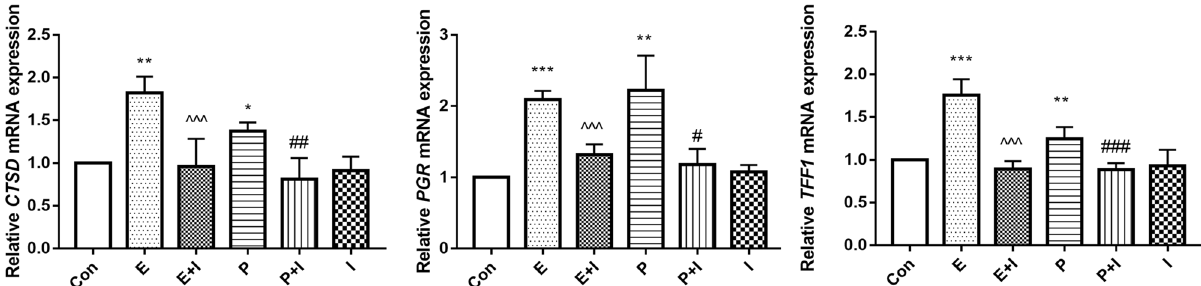
Figure 6. Effects of psoralen on the expression of estrogen target genes in hPDLCs. Cells were divided into 6 groups: Con, control group; E, estrogen (10 –8 M) group; P, psoralen (12.5 μg/mL) group; E + I, estrogen (10 –8 M) + I (1 μM) group; P + I, psoralen (12.5 μg/mL) + I (1 μM) group; I, I (1 μM) group (* p < 0.05,** p < 0.01,*** p < 0.001 compared with the control group, # p < 0.05, ## p < 0.01, ### p < 0.001 compared with